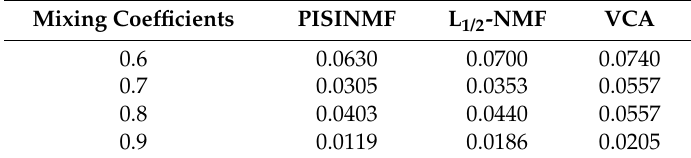
Figure 11. Experimental results with different abundance mixing coefficients: ( a ) RMSE; ( b ) SAD. Table 5. SAD comparison with different abundance mixing coefficients.